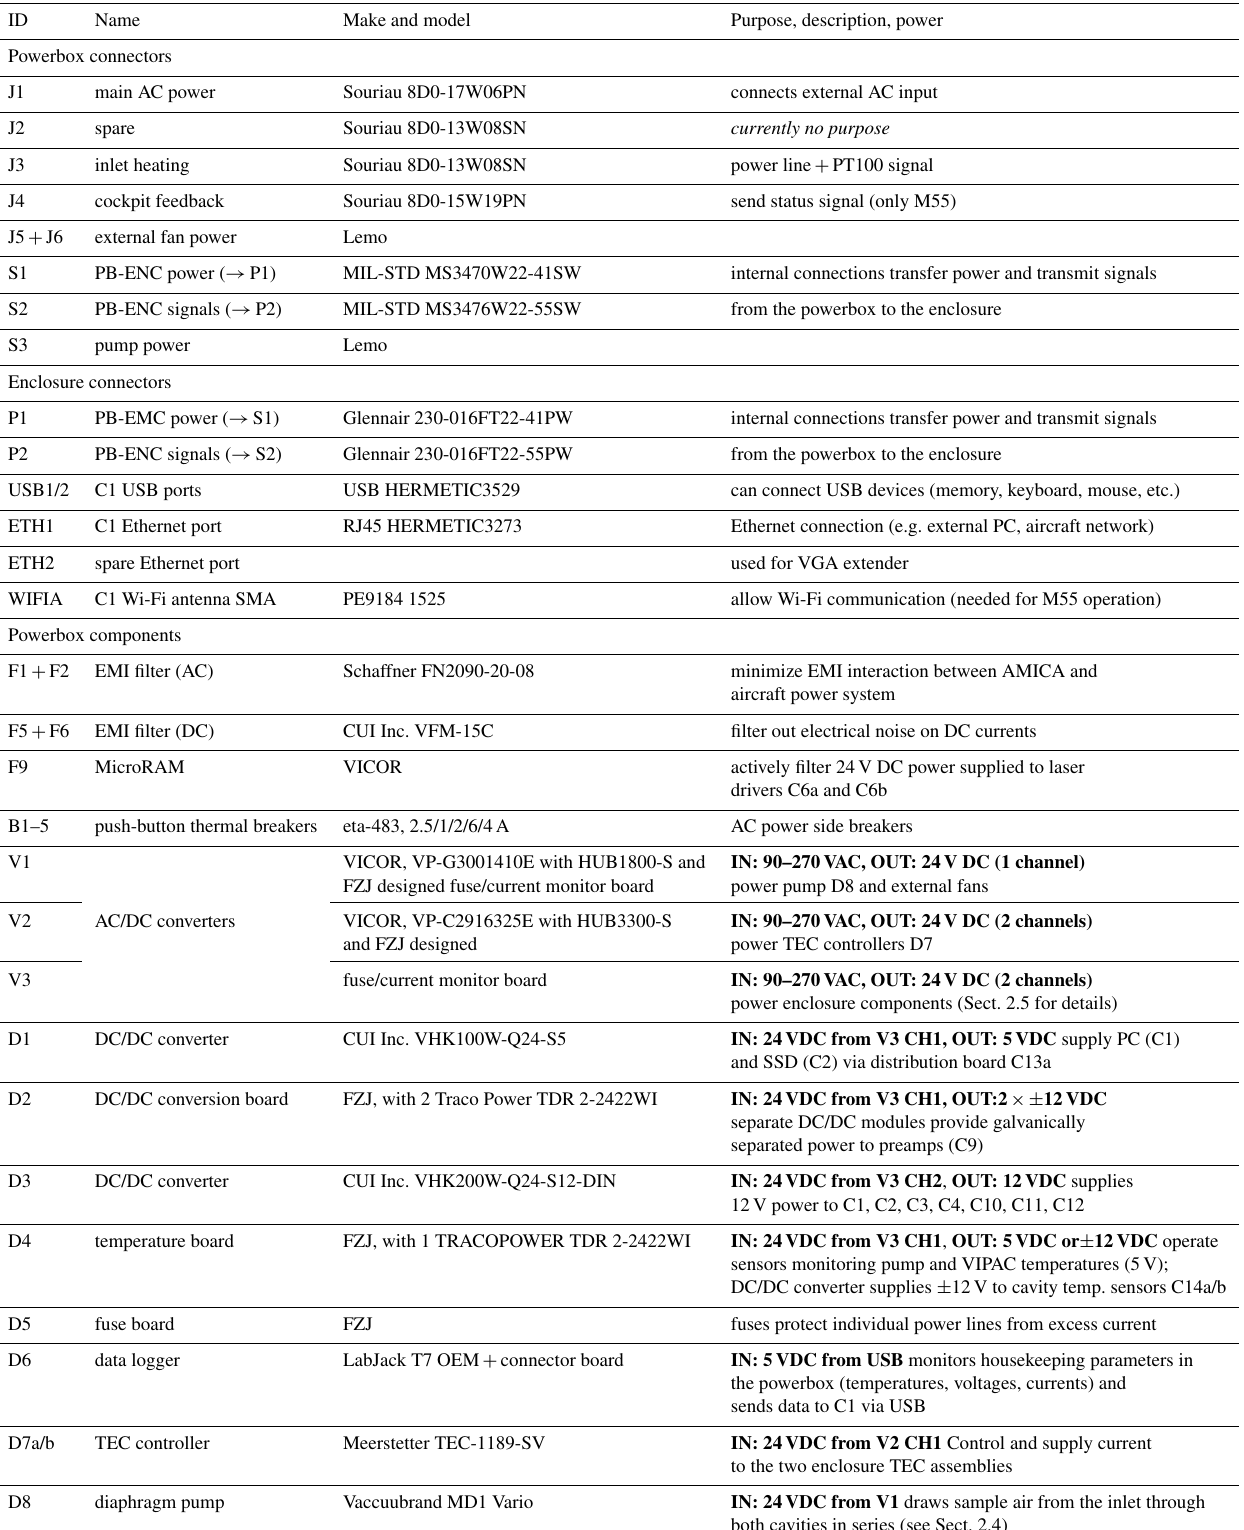
Table 2. List of connectors and functional components in AMICA with information on specifications and purpose. Bold face in the fourth column shows components’ power source (and output, in case of power